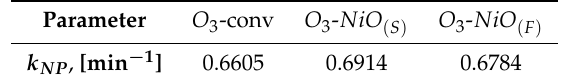
Table 1. Reaction rate constants for the NP degradation by conventional and catalytic